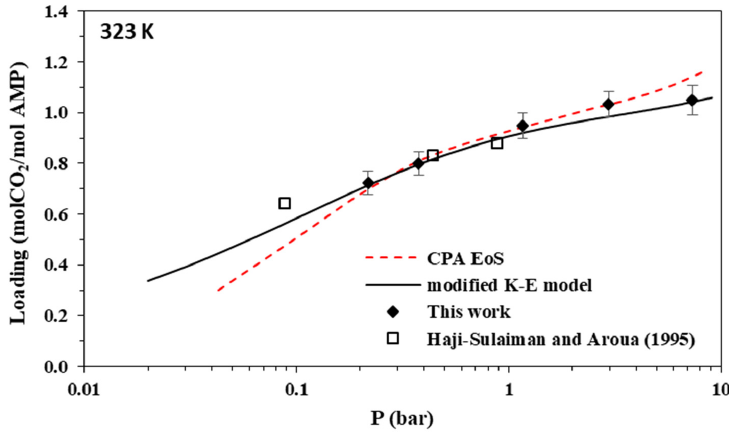
Figure 5. Solubility of CO 2 in aqueous AMP (17.7% wt.) solutions at 323 K. Experimental data (points, from this work and Hadji-Sulaiman and Aroua [32]) and correlations (lines) with the CPA equation of state and the modified Kent–Eisenberg model.